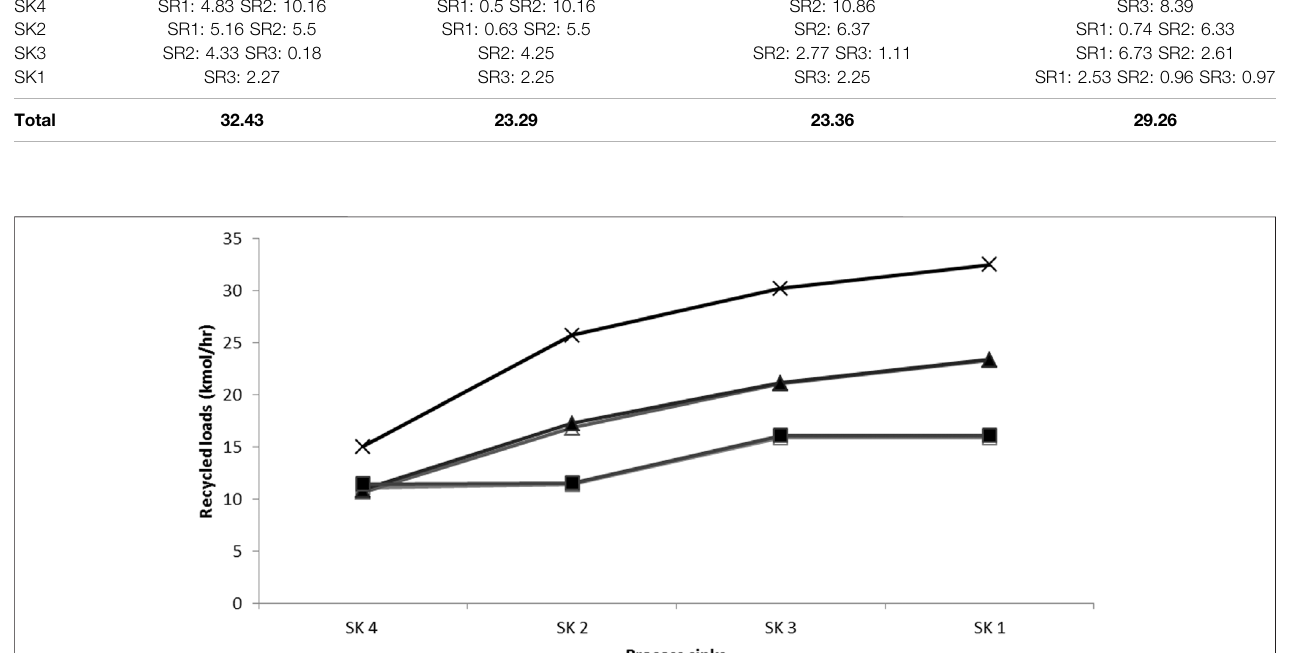
FIGURE 8 | Cumulative curve of the optimal recycled loads in the case study-2 (SMI NPM : crosses; SMI RPM at b (cid:1) 0% for single-variable sequential optimization at each process selection step: hollow squares; SMI RPM at b (cid:1) 0% for multi-variable simultaneous optimization at each process selection step: full squares; SMI RPM at optimal b (cid:1) 5% for single-variable sequential optimization at each process selection step: hollow triangles; SMI RPM at optimal b (cid:1) 5% for multi-variable simultaneous optimization at each process selection step: full